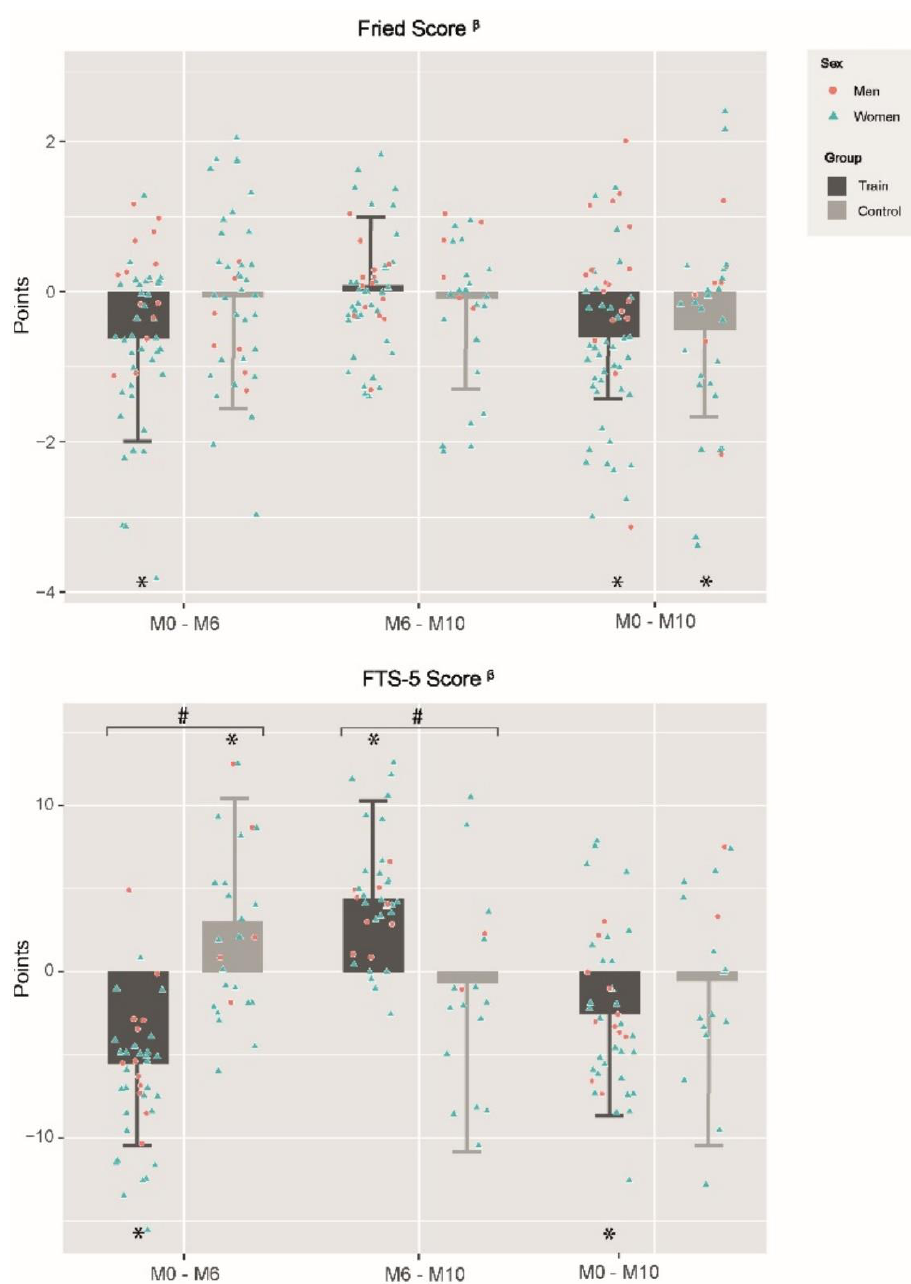
Figure 2. Changes in Fried´s Frailty Phenotype and FTS-5 between and within groups in different evaluation periods. M0 – M6: changes between baseline and 6th month; M6 – M10: changes between 6th and 10th month; M0 – M10: changes between baseline and 10th month; CON: Control Group; TRAIN: Training Group; FTS-5: Frailty Trait Scale of 5-items; *: Statistical significance within group changes; #: group effects; β : negative changes represent frailty diminution; Differences were obtained by linear mixed models adjusting by baseline values, gender and age; Statistical significance was set at p < 0.05.